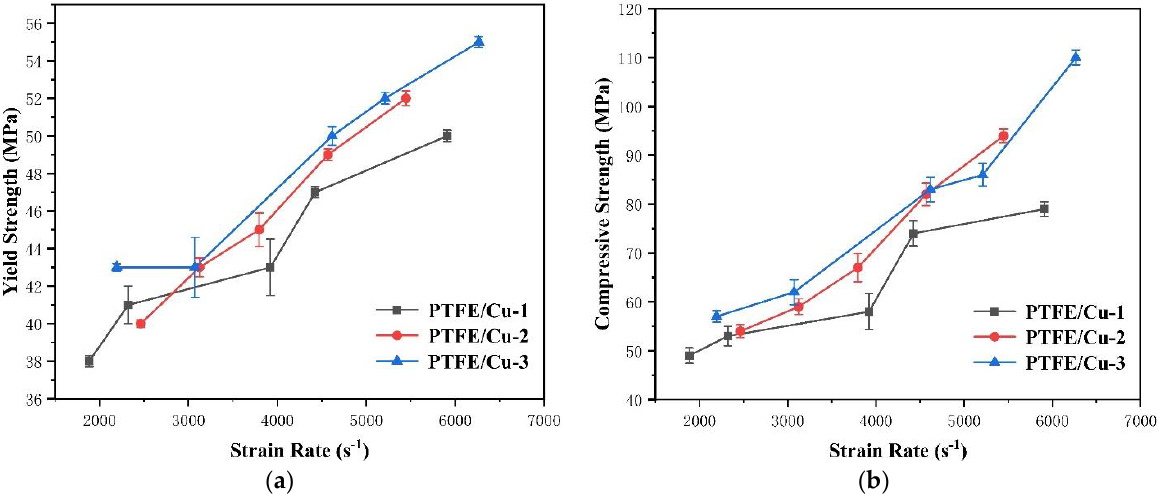
Figure 7. Parameters of dynamic mechanical properties of PTFE/Cu composites with different densities: ( a ) yield strength; ( b ) Compressive strength.